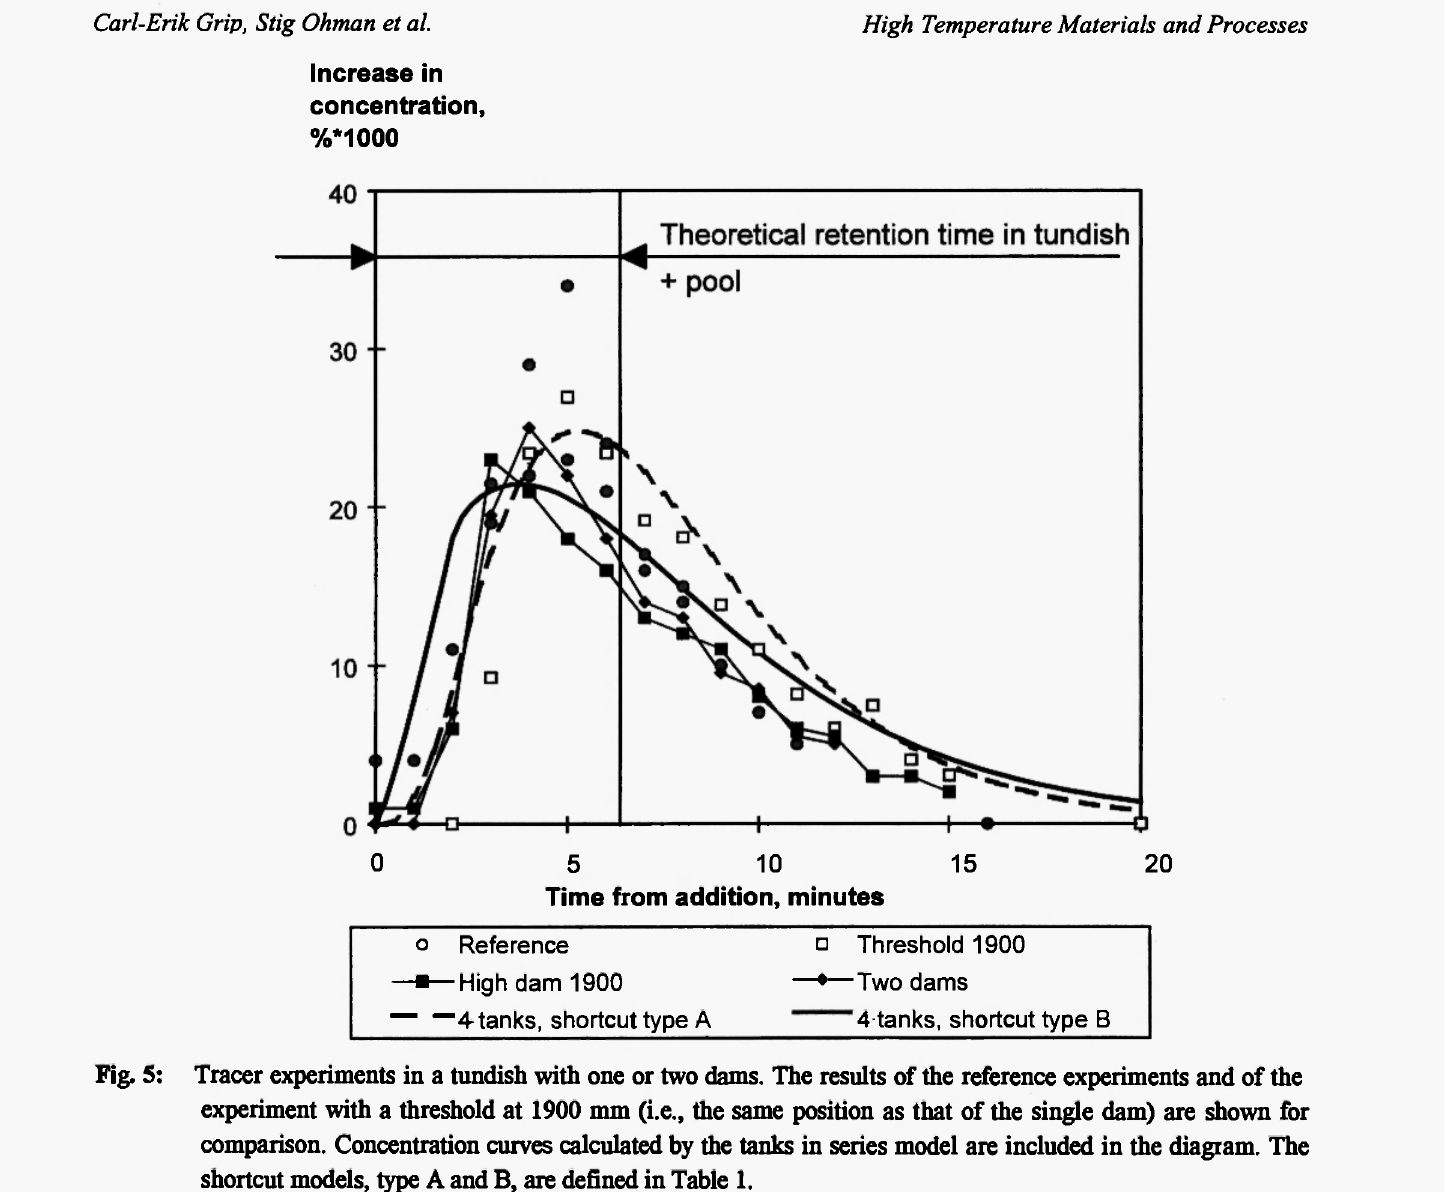
Tracer experiments in a tundish with one or two dams. The results of the reference experiments and of the experiment with a threshold at 1900 mm (i.e., the same position as that of the single dam) are shown for comparison. Concentration curves calculated by the tanks in series model are included in the diagram. The shortcut models, type A and B, are defined in Table